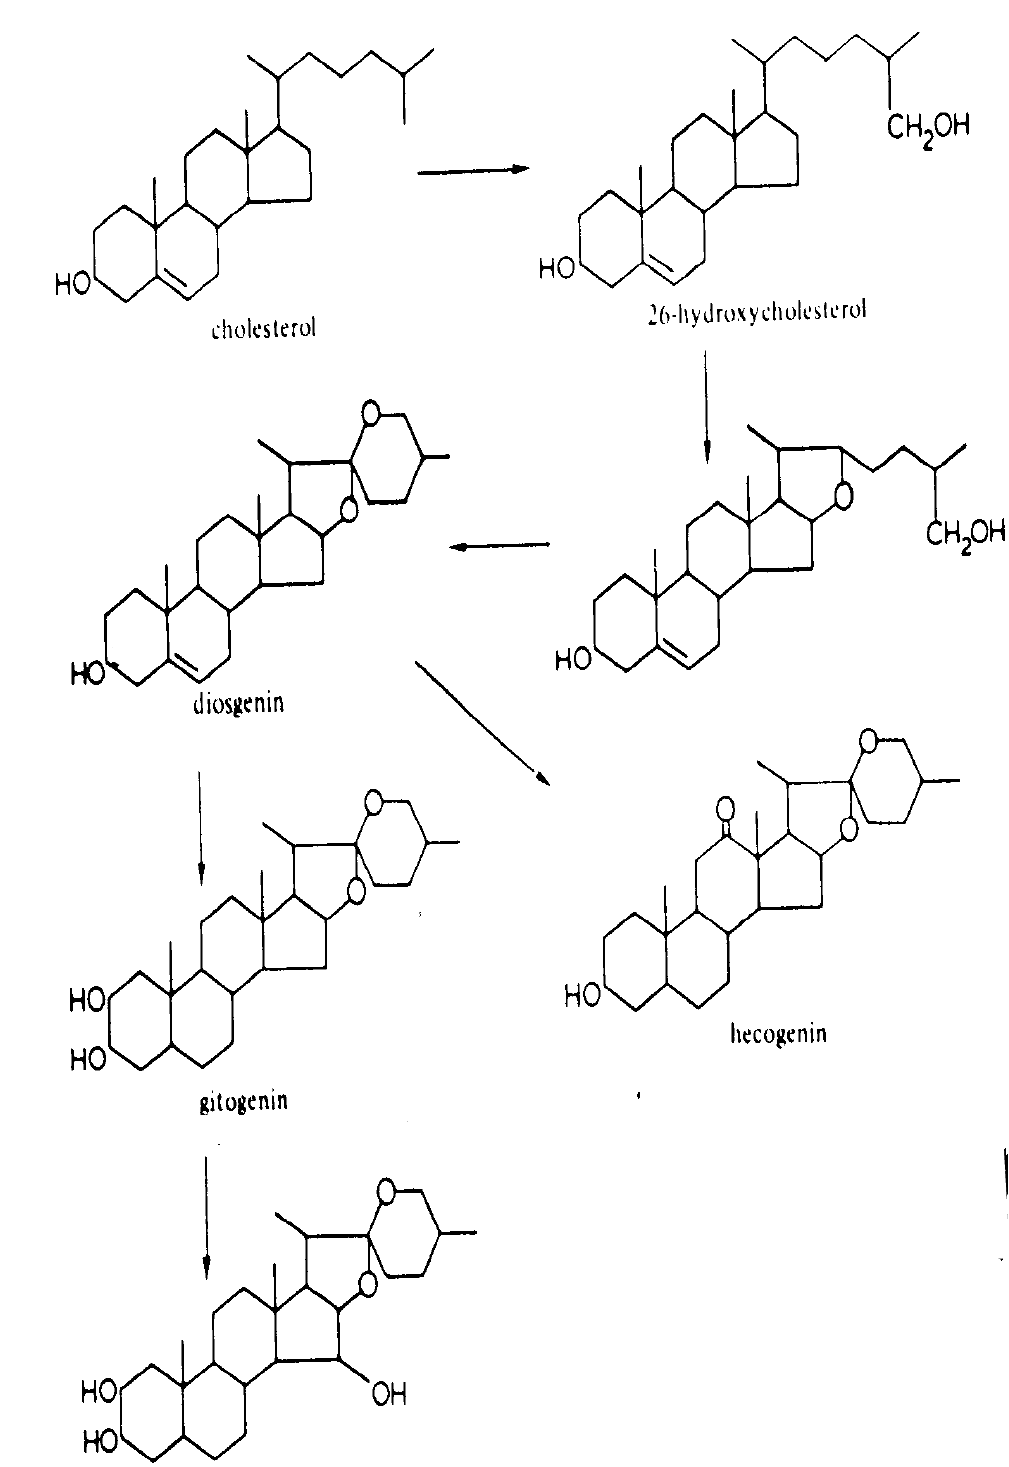
Figure 2 : The biosynthesis of steroidal sapogenin digitogenin